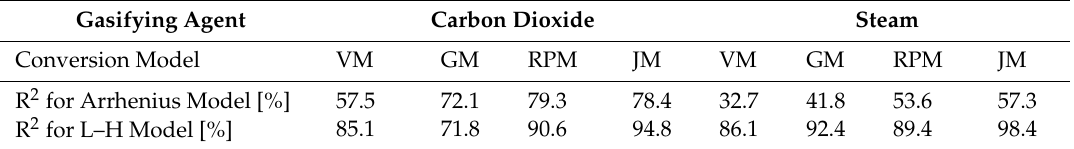
Table 5. Coe ffi cient of determination R 2 for all model combinations.